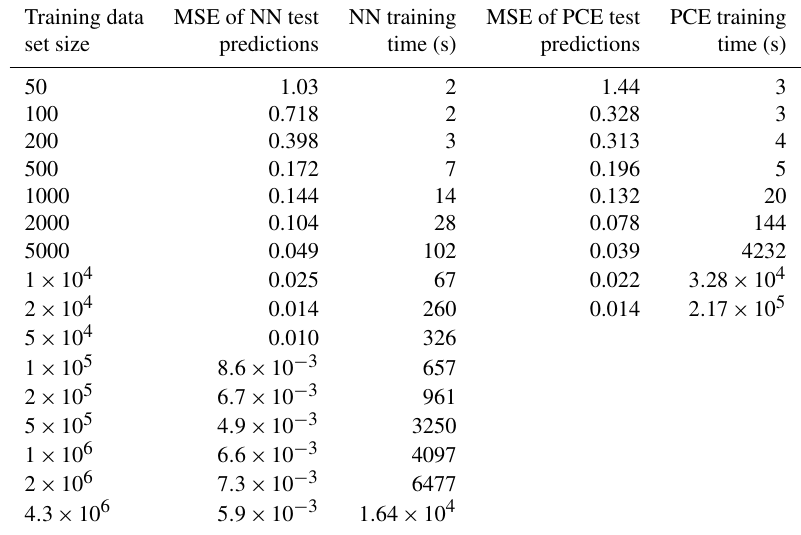
Table 2. Training times of surrogate models with the NN and PCE